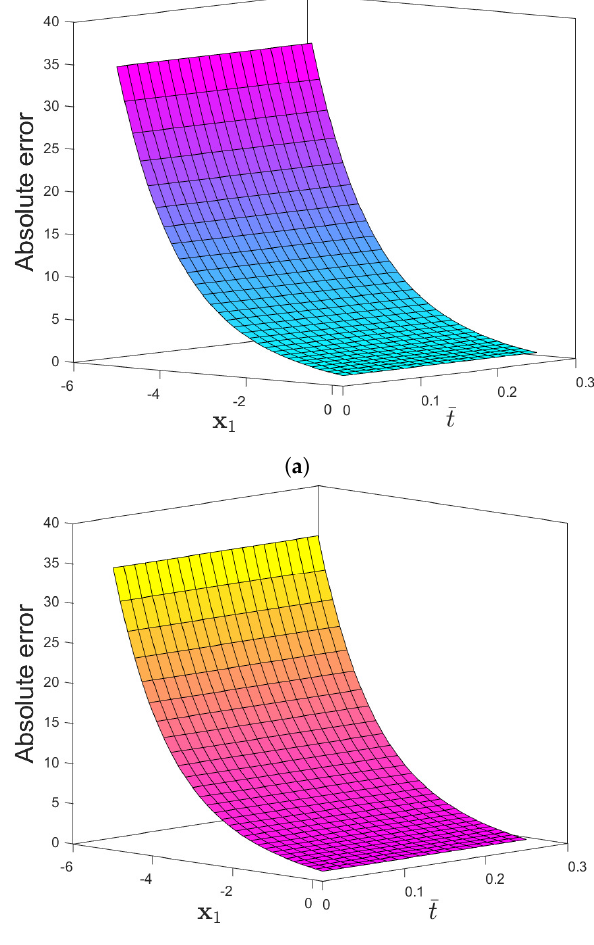
Figure 11. ( a ) Absolute-error plots of f ( x 1 , ¯ t ) for Problem 3 for (textbfa) CFD and ( b ) ABC when the parameters are θ = 1, β = 1, and ϕ = 1/10.